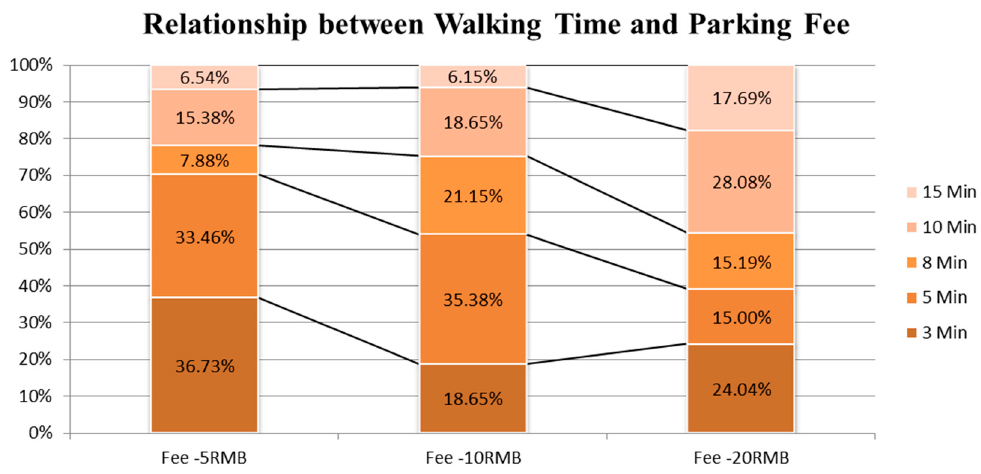
Figure 2. Relationship between the walking time and parking fee.